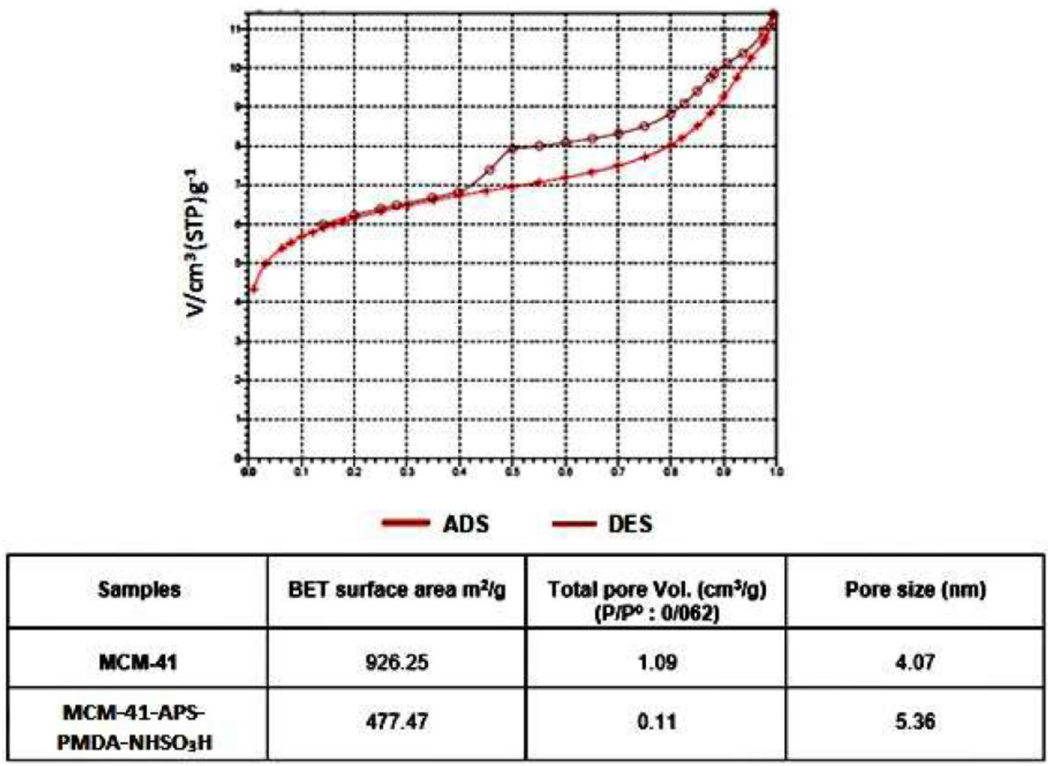
Figure 6. Adsorption/desorption isotherm of the MCM-41-APS-PMDA-NHSO 3 H nanocatalyst ( 1